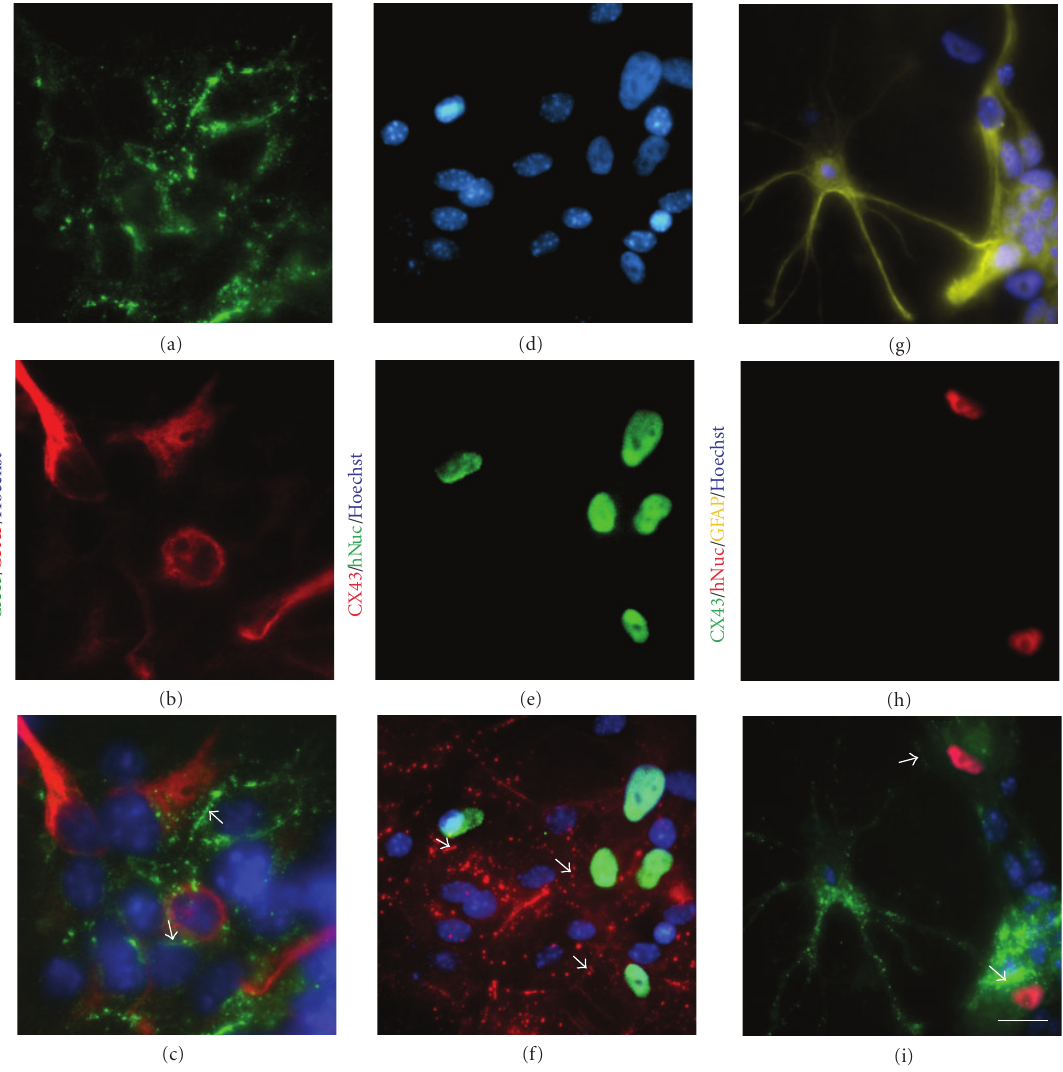
Figure 4: AF cells form gap junctions with cortical astrocytes in vitro. Immunocytochemistry showed that AF cells established gap junctions with cortical astrocytes. (a)–(c) CX43 (green) was expressed at the boundary between AF cells and GFAP- (red) positive cortical astrocytes. (d)–(f). In parallel experiments, AF cells labeled with an antibody against human-specific nuclear antigen (hNuc, green) showed discrete, punctuate CX43 (red) staining at the cellular boundary with cortical cells (arrows). (g)–(i). To determine the identity of cortical cells, similar cultures were stained with GFAP (yellow), hNuc (red), and Cx43 (green). Hoechst (blue) was used as a counter-stain. Scale bar: 8 μ m (a)–(c), 15 μ m (d)–(f), 20 μ m